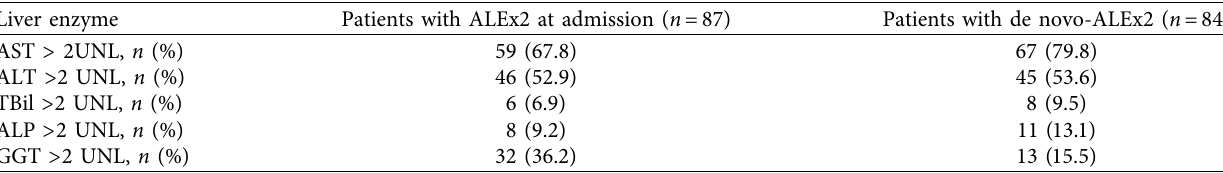
Table 3: Distribution of abnormal liver enzymes at admission and at 1 week of hospitalization.